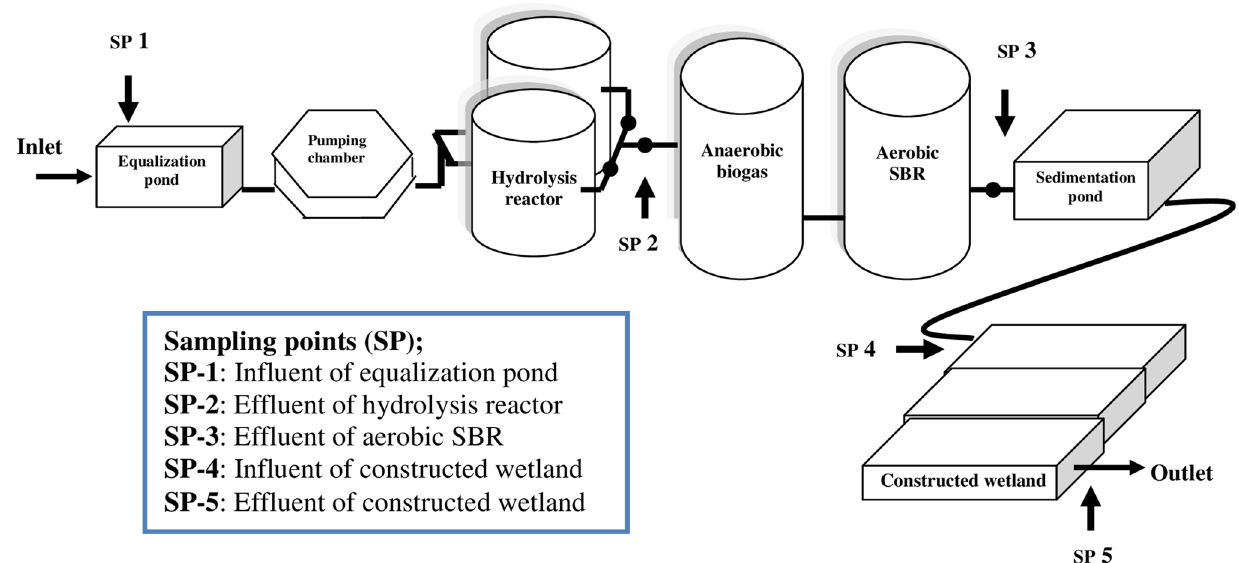
Fig. 2 Schematic of the integrated wastewater treatment plant and sampling points